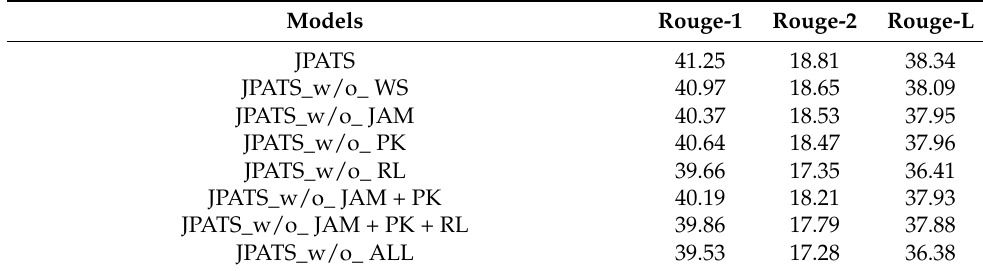
Table 4. JPATS ablation experiment scores on dataset